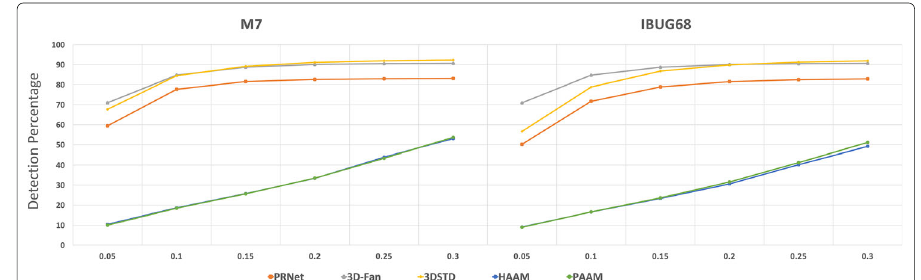
Fig. 8 Results with M7 (left) and iBUG (right) landmarks are both plotted for comparison. Performance respect to thresholds using 68 pts